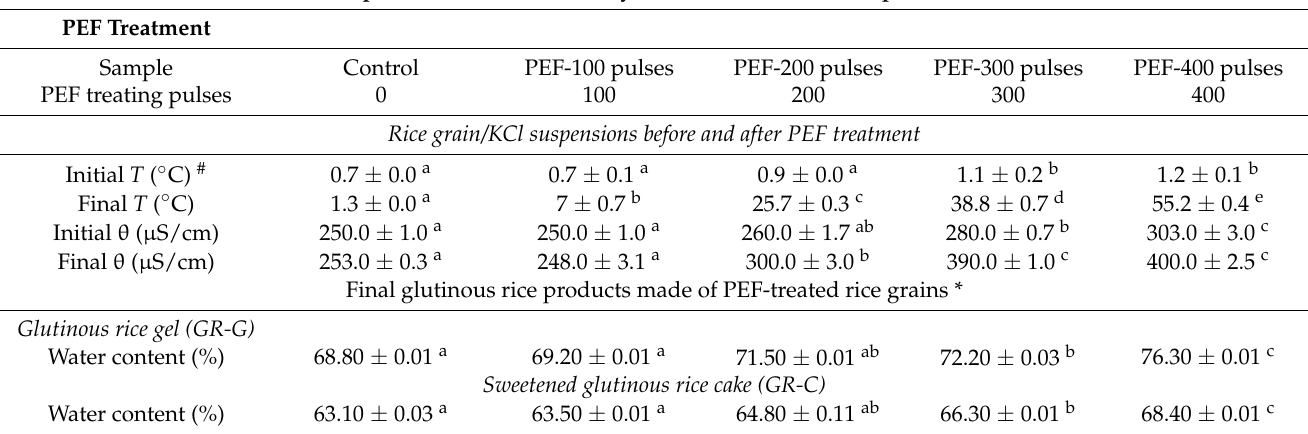
Table 1. Temperature and conductivity of rice grain suspensions before and after 100–400 pulses at 3 kV/cm of PEF treatment. Moisture content ( w / w , wet basis) of fresh-made glutinous rice gel samples (GR-G) and sweetened glutinous rice cake samples (GR-C) with or without PEF treatment. Temperature and Conductivity of PEF-Treated Rice Suspensions